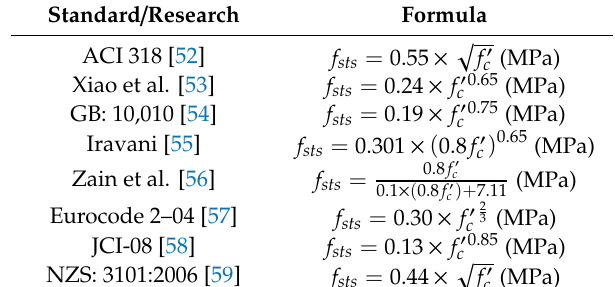
Figure 6. Predictions of various codes for the CS and STS of RAGC mixes. Table 5. Relationships between CS and STS of plain concrete available in the literature.